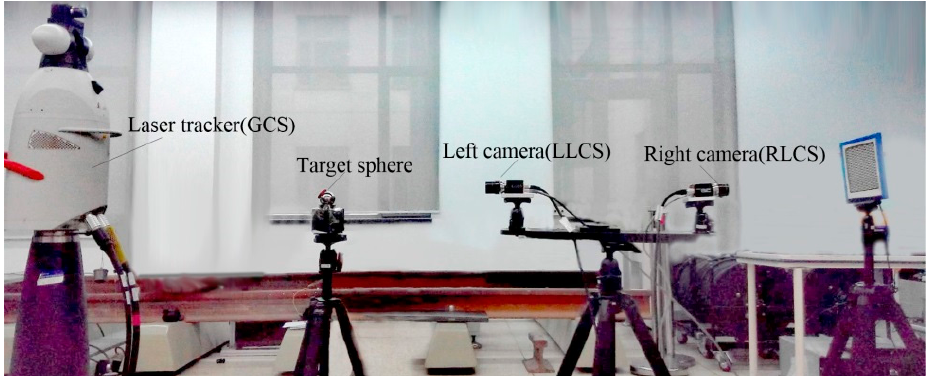
Figure 2. Experimental layout for the global calibration of two non-overlapping